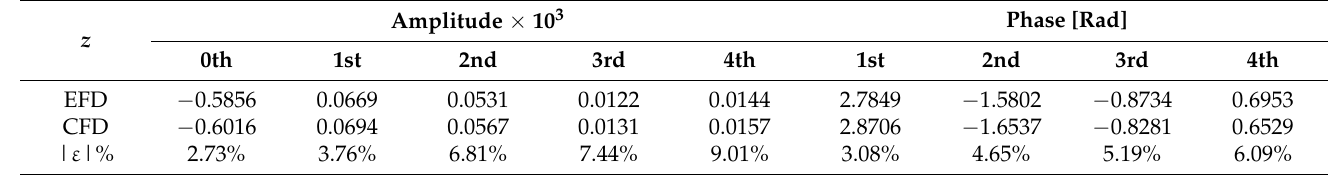
Table 26. Harmonic amplitudes and phases of heave for the FRxz ϕθ following waves scenario.